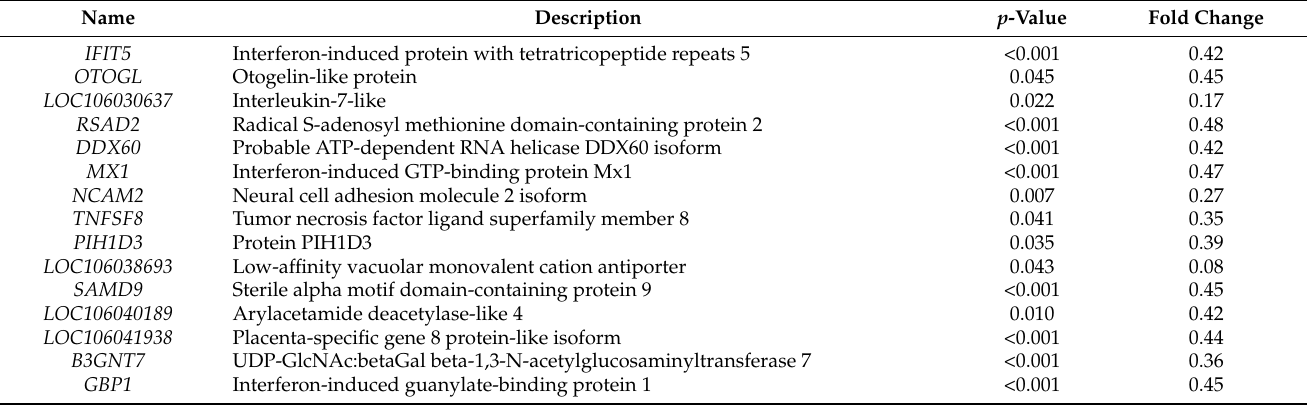
Table 3. The downregulated genes in hepatocytes transfected with pcDNA3.1(+) containing goose OTU deubiquitinase 7A CDS and an empty vector.